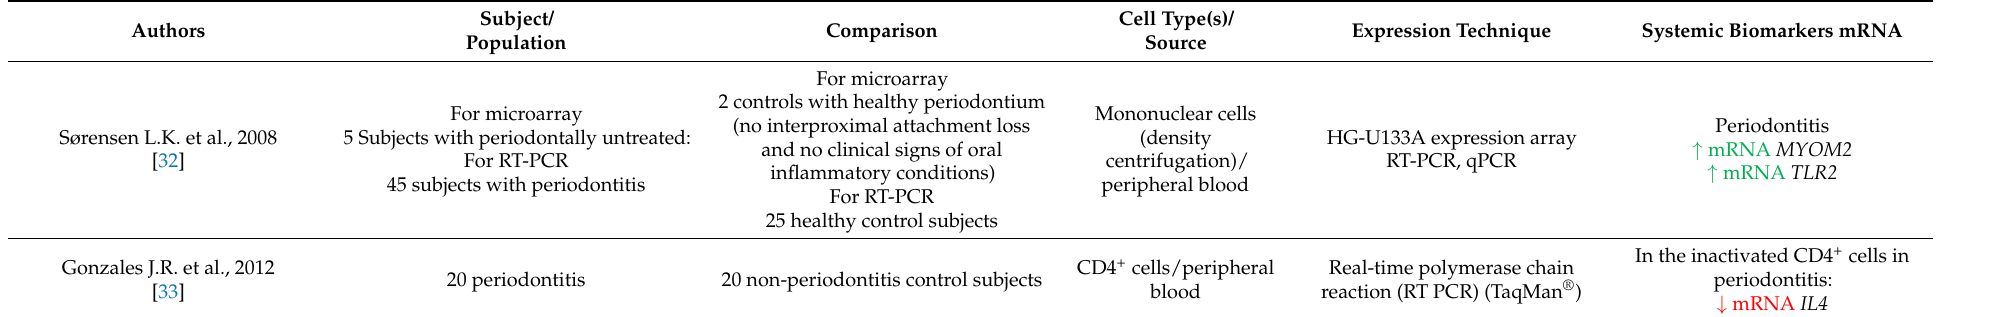
Table 8. Studies on mRNA expression in peripheral blood mononuclear cells (PBMCs) or subcomponents (lymphocytes and